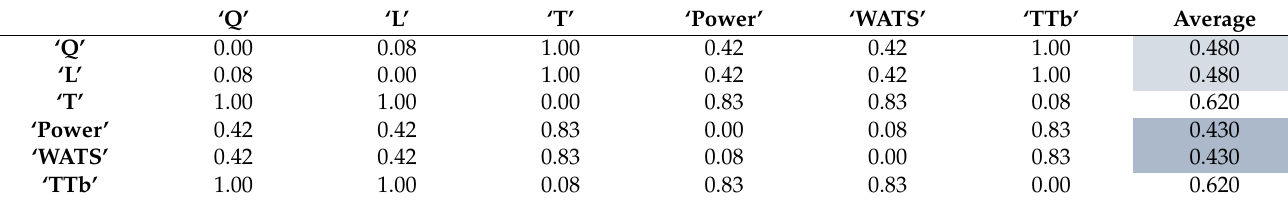
Table 6. Distances between the objectives for Case